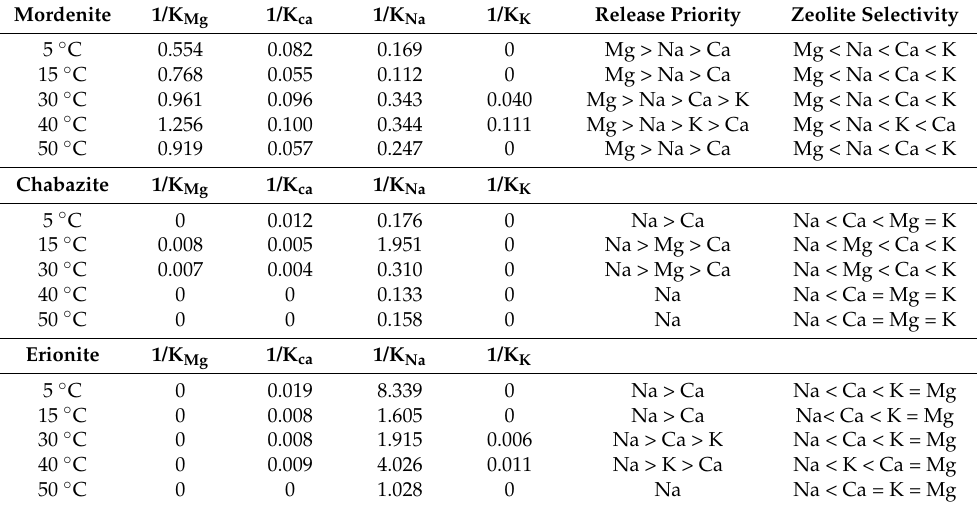
Table 3. Release ability of each cation in zeolites and zeolite selectivity under different